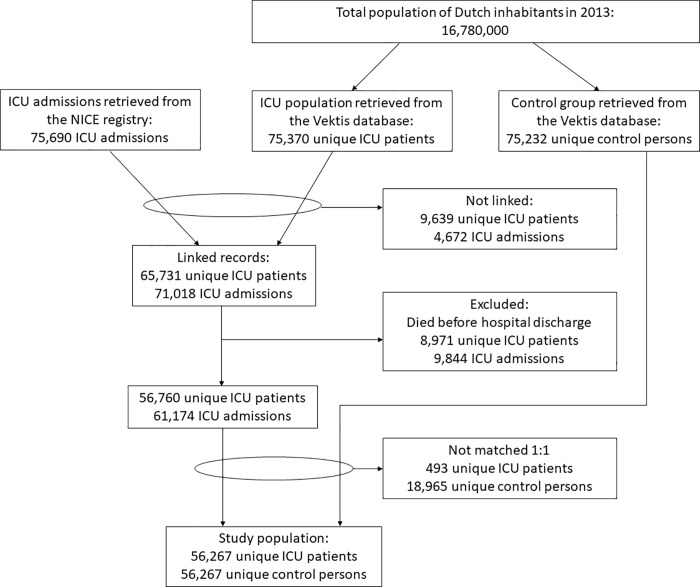
Flowchart of the linking and matching process.